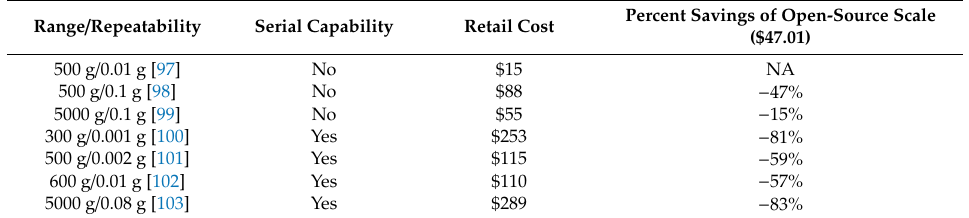
Table 6. Several proprietary scales listed online were compared in price and capability to the open-source scale. This was done to indicate the cost savings allowed by the open-source scale, which vary greatly depending on the functionality and range